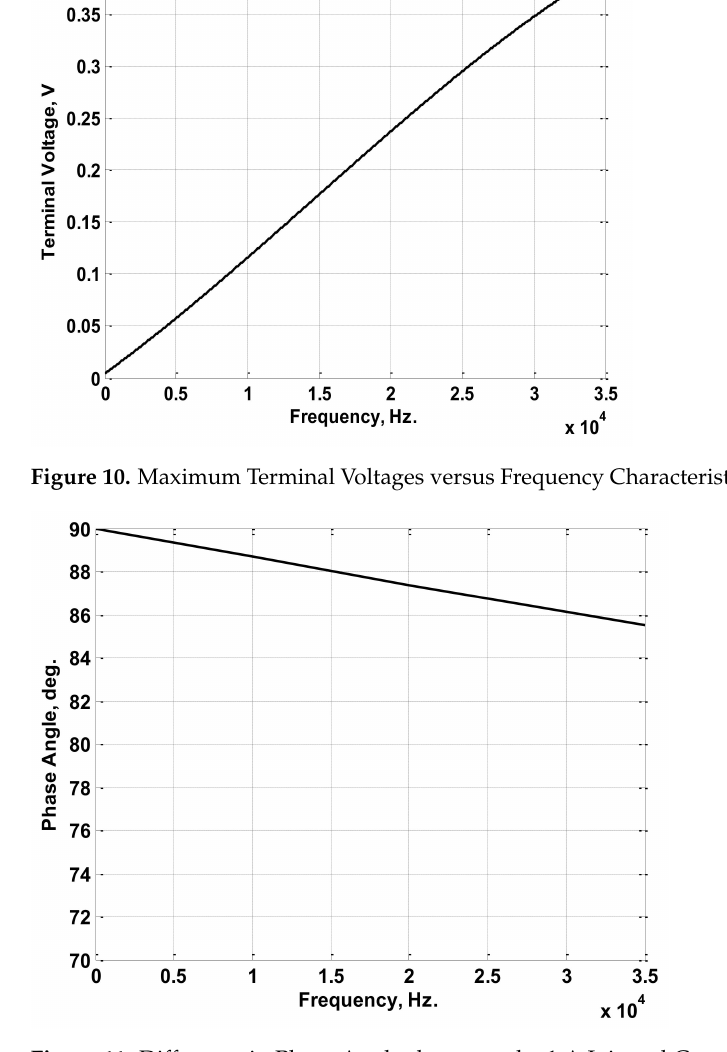
Figure 11. Difference in Phase Angles between the 1 A Injected Current and the Terminal Voltage versus Frequency Characteristics of the Experimental